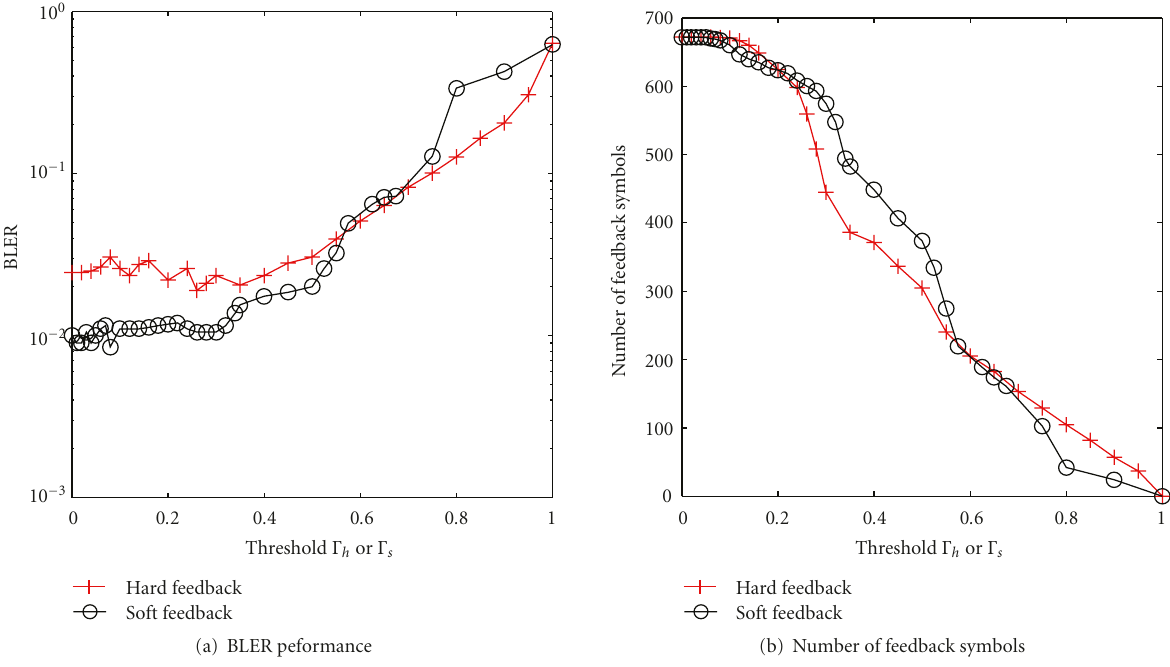
Figure 2: BLER peformance (a) and number of feedback symbols (b) for hard and soft feedback with varying threshold Γ h or Γ s ; SNR of